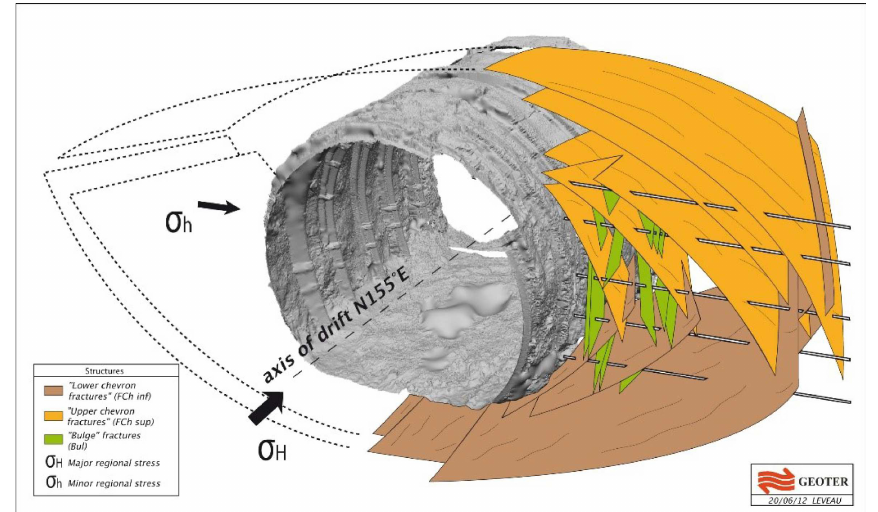
Fig. 3. Conceptual model of the excavation-induced fractures network in Callovo-Oxfordian claystone (Meuse/Haute-Marne URL,